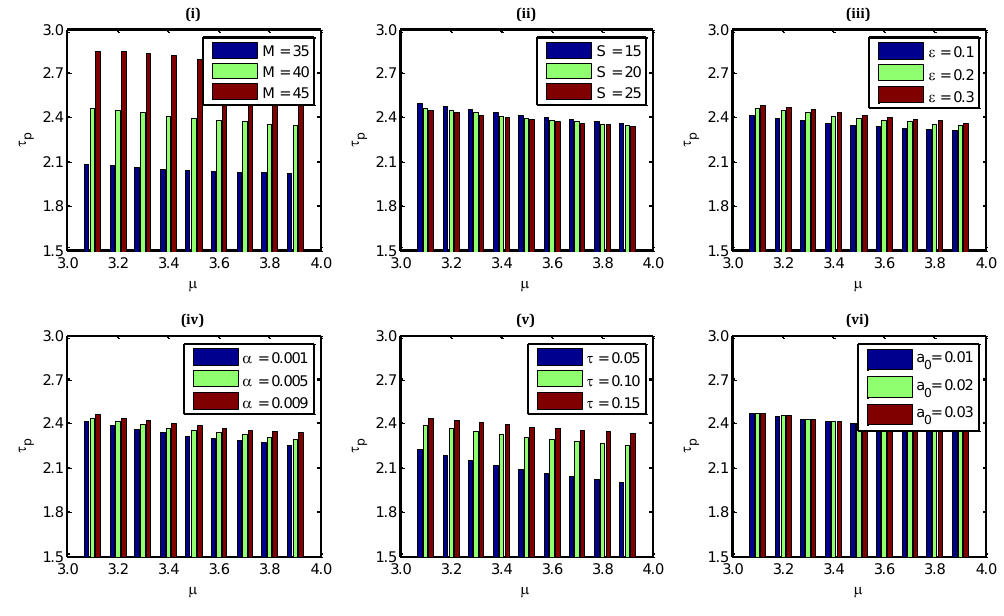
( )  wrt service rate of the failed machines ( )  . p